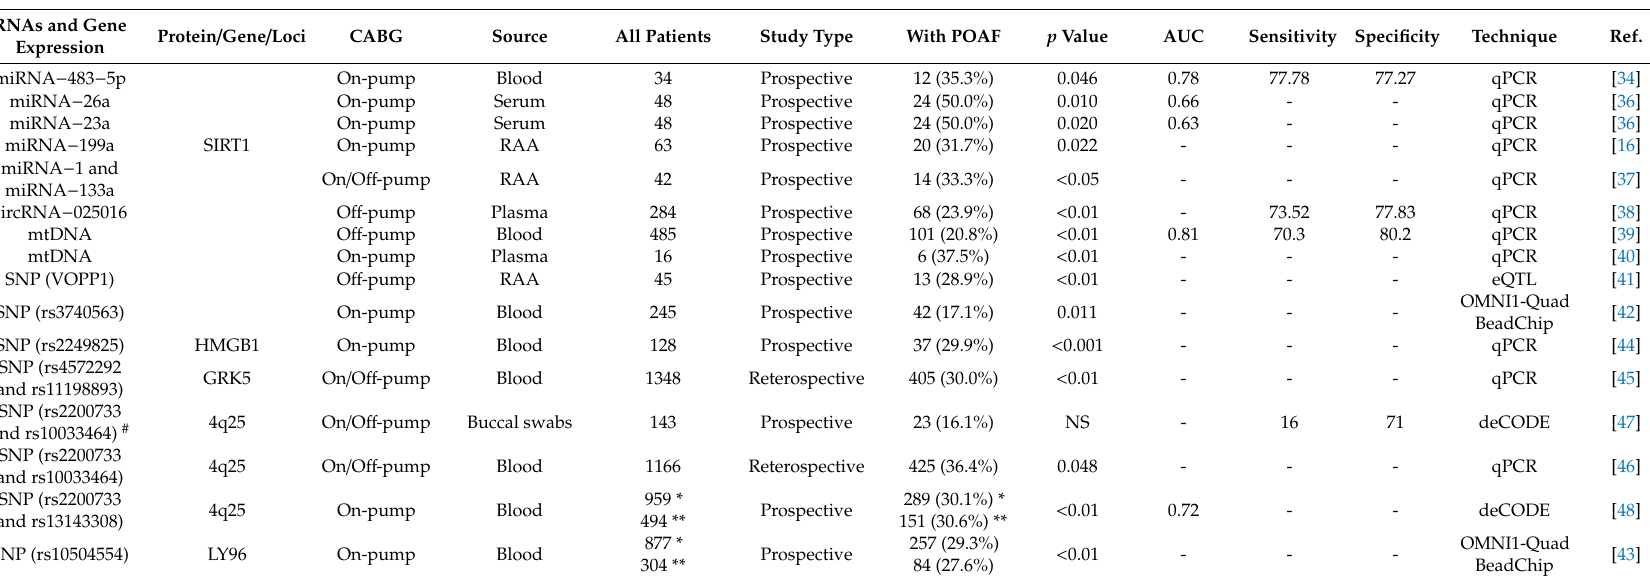
Table 1. mi / circRNAs and other gene expressions recently reported to be used as predictors of POAF development among CABG patients. RNAs and Gene